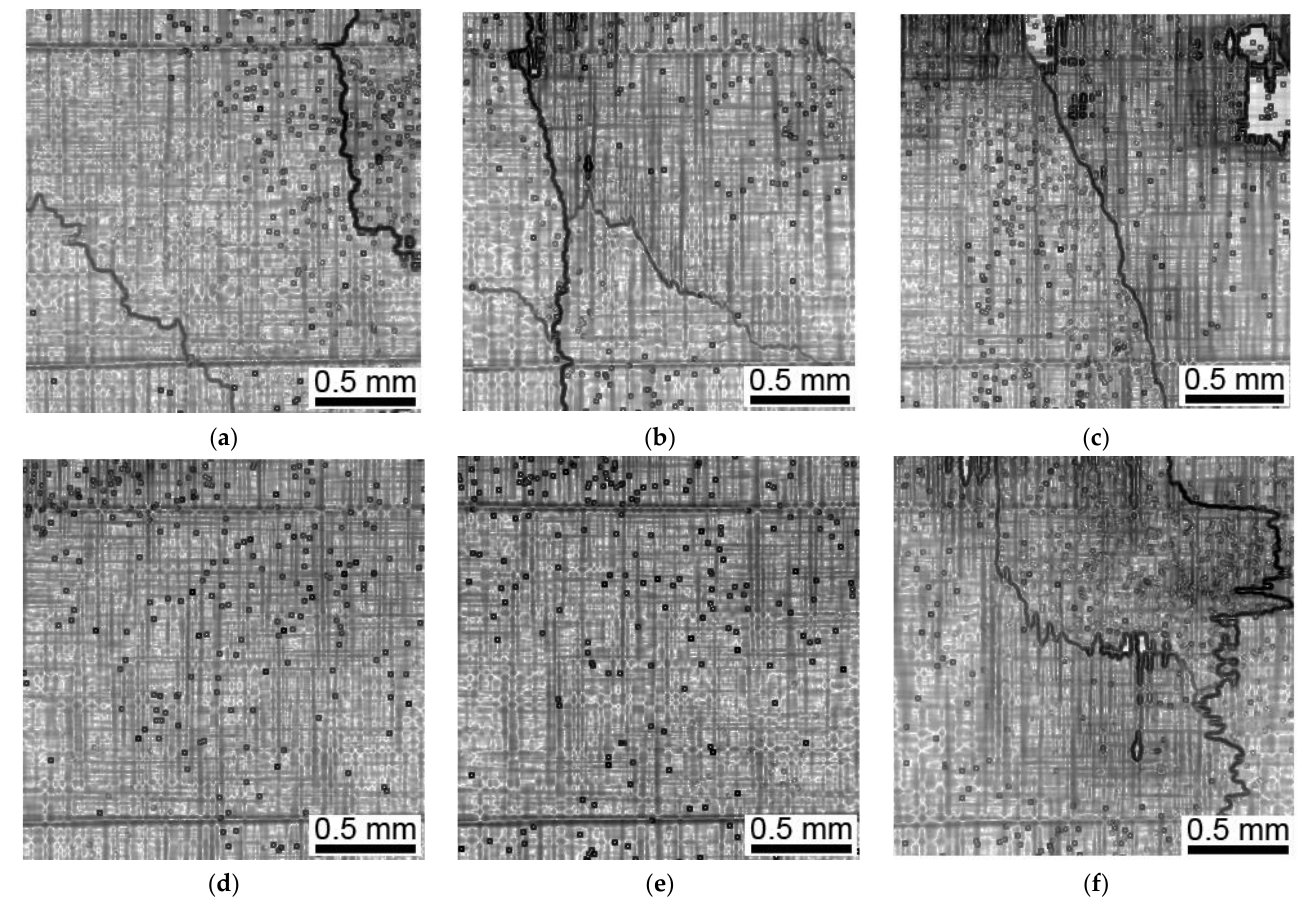
Figure 19. Evolution of deformation structures in the neck area for steel: ( a ) ε = 0.021, ∆ ε = 0.020; ( b ) ε = 0.045, ∆ ε = 0.016; ( c ) ε = 0.082, ∆ ε = 0.020; ( d ) ε = 0.164, ∆ ε = 0.040; ( e ) ε = 0.164, ∆ ε = 0.020; ( f ) ε = 0.196, ∆ ε = 0.040 . All pseudo-images on ( a – f ) are obtained at T = 1.